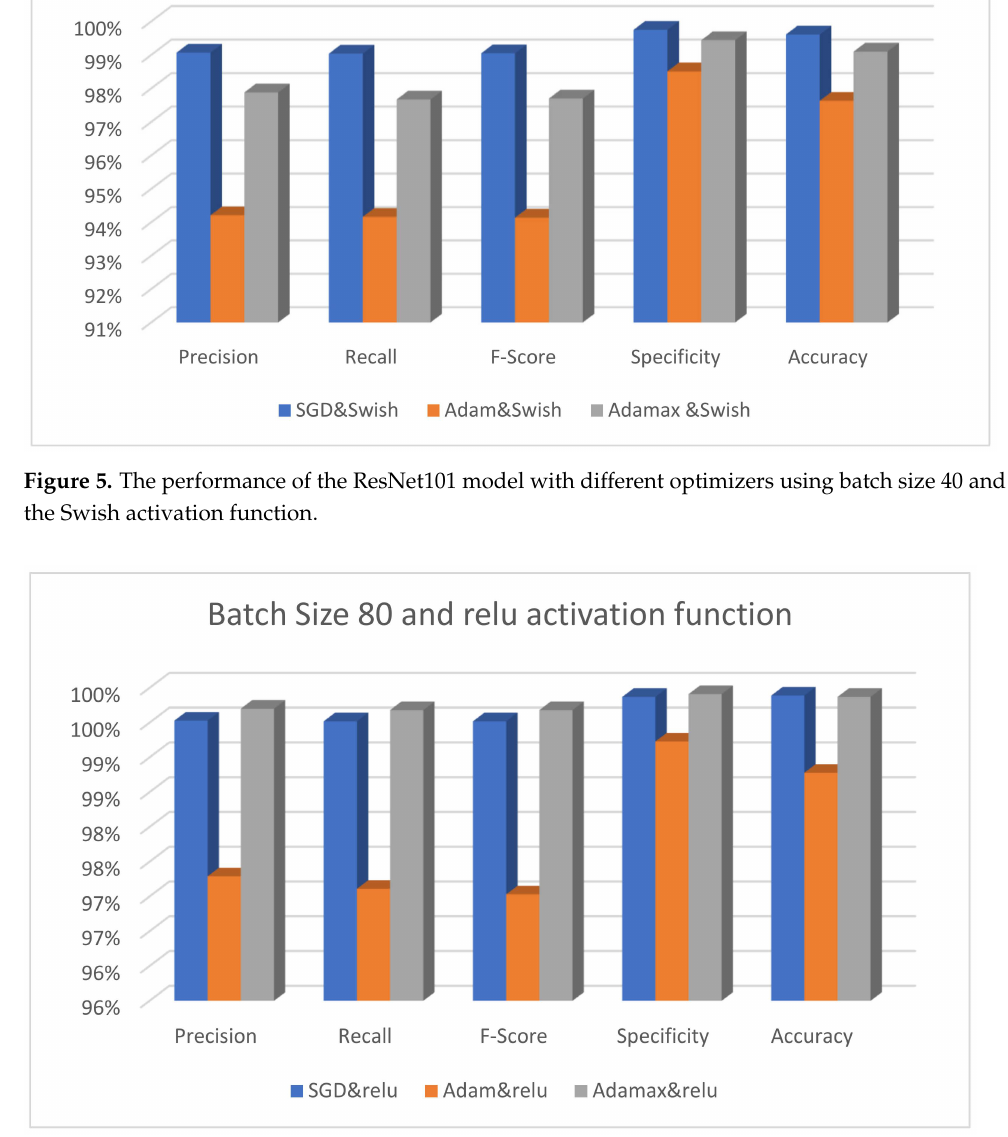
Figure 6. The performance of the ResNet101 model with different optimizers using batch size 80 and the Swish activation